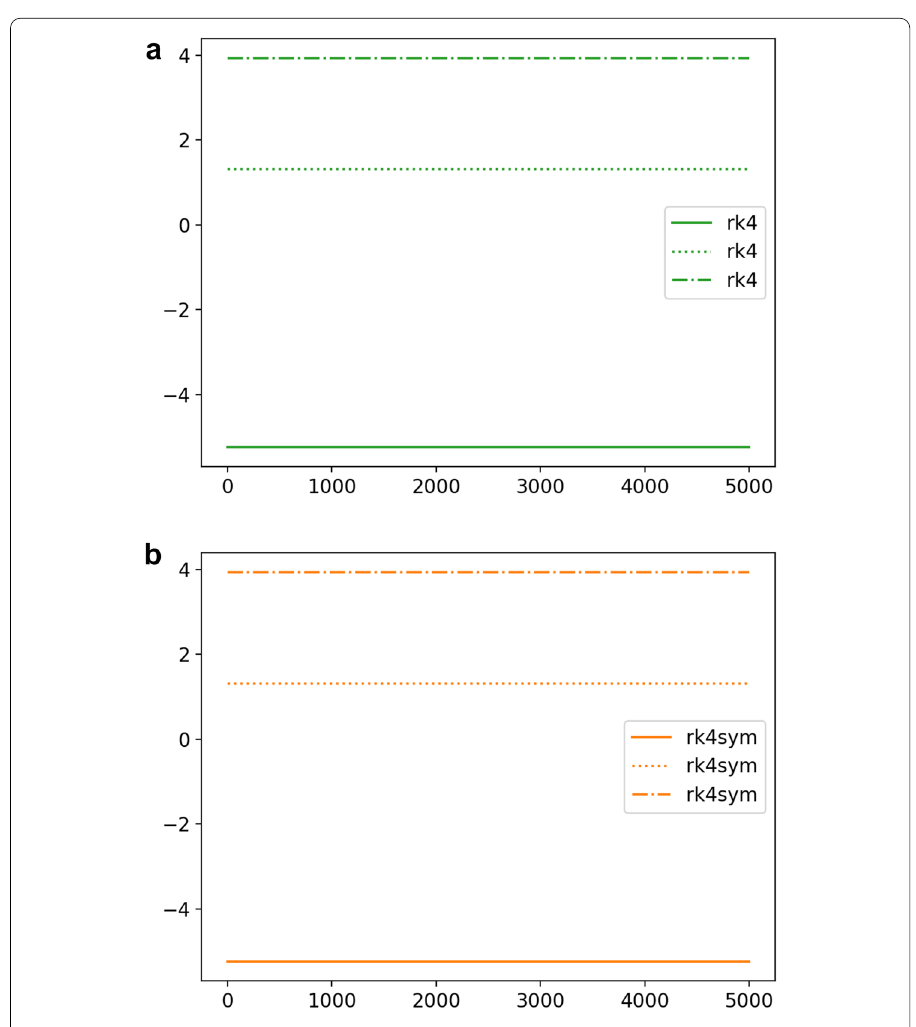
Fig. 2 Toda lattice. Evolution of the eigenvalues of L with (cid:5) t = 10 − 2 . a RK4. b